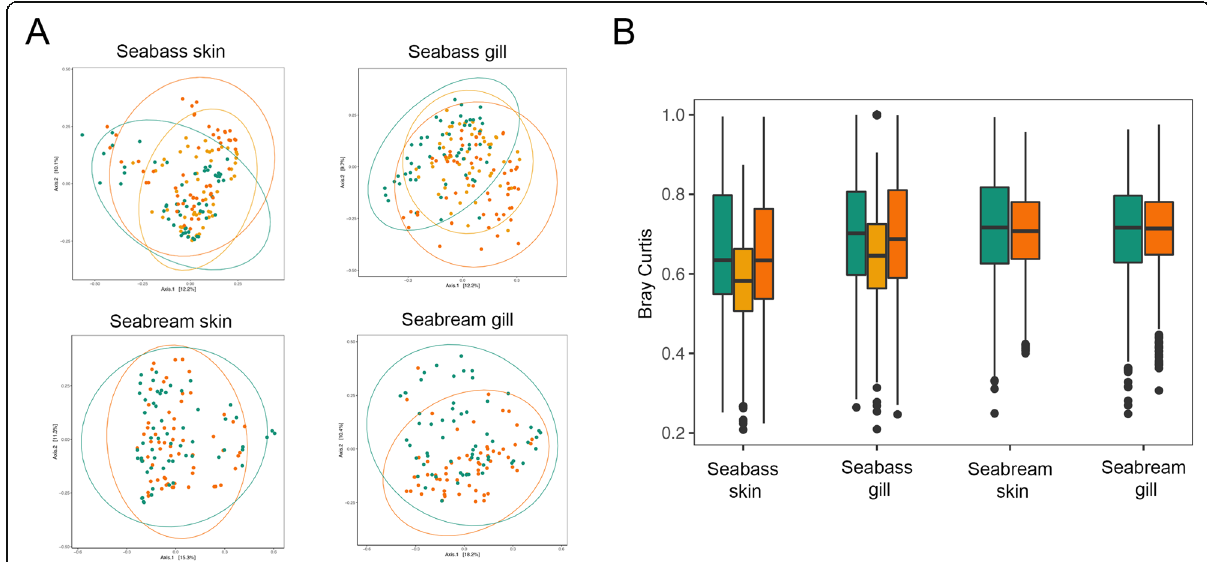
Fig. 2 a PCoA plots computed using Bray-Curtis distances. Each dot represents a microbiome sample and is colored by age group (green: early juveniles/juveniles; yellow: late juveniles; orange: mature adults) in seabass Dicentrarchus labrax and seabream Sparus aurata . Ellipses denote a 95% confidence for the age group mean. b Bray-Curtis beta-diversity within age groups plotted for the early juveniles/juveniles (green), late juveniles (yellow) and mature adults (orange) of the seabass Dicentrarchus labrax and the seabream Sparus aurata ( n = 60 per species x age group x